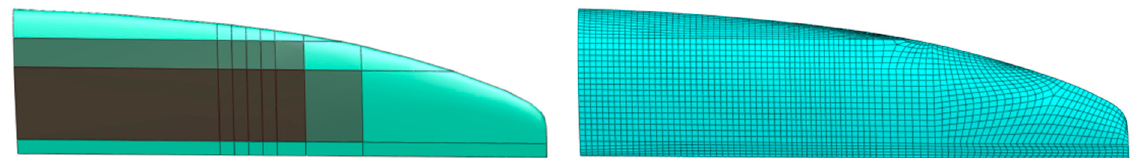
Figure 2. FEA Partitions (shaded areas = UD tapes) and mesh.